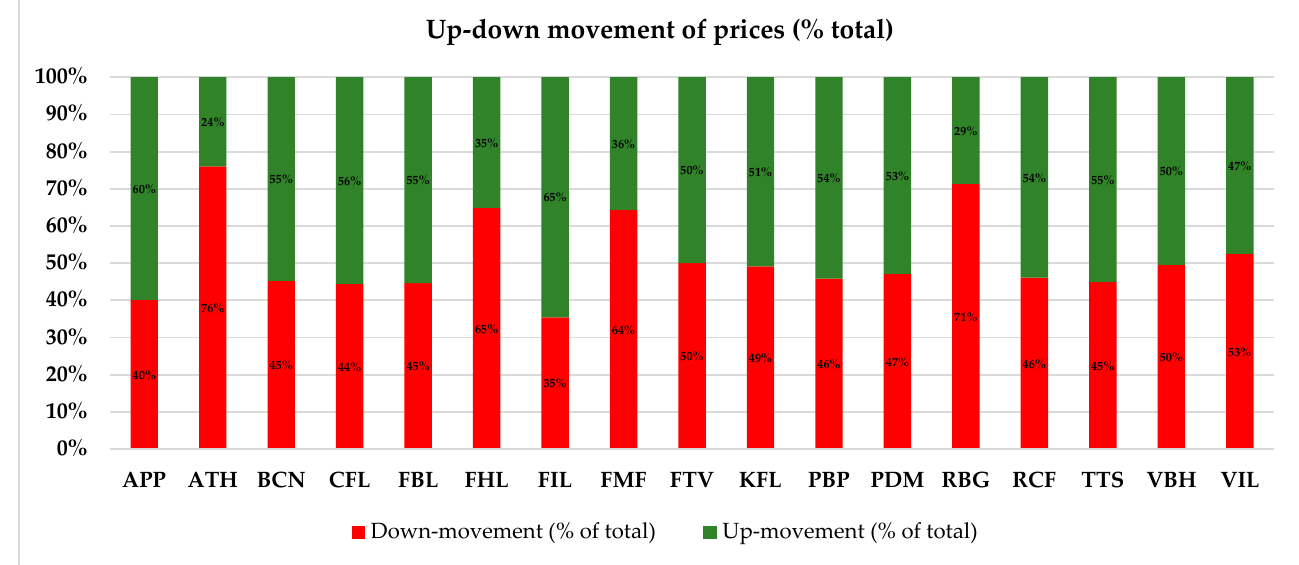
Figure 4. Source: Authors’ calculation based on the data from the SPX website.